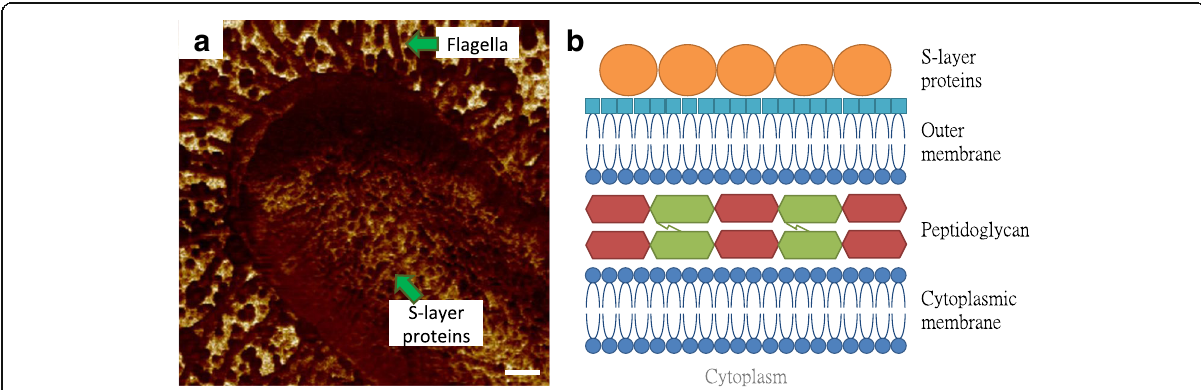
Fig. 2 Illustration of vertical and surface structures of E. coli cells. a The surface macromolecules on E. coli MG1655 cell imaged by AFM adhesion mapping. b The molecular architecture of cell envelope in Gram-negative microbes, which consists of cytoplasmic membrane, peptidoglycan, outer membrane, and S-layer. The scale bar = 200